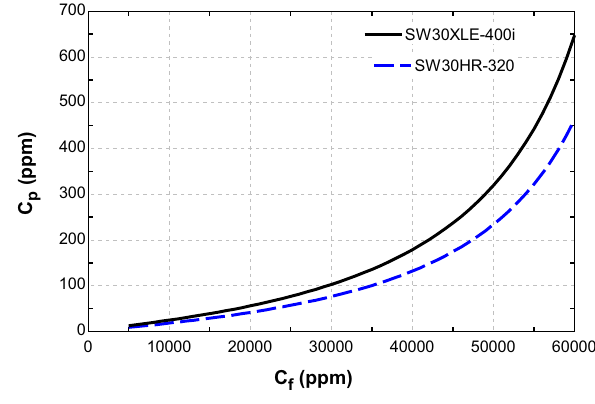
Fig. 6 Sensitivity analysis of produced fresh water concentration on membrane change at different concentrations of inlet water on a membrane